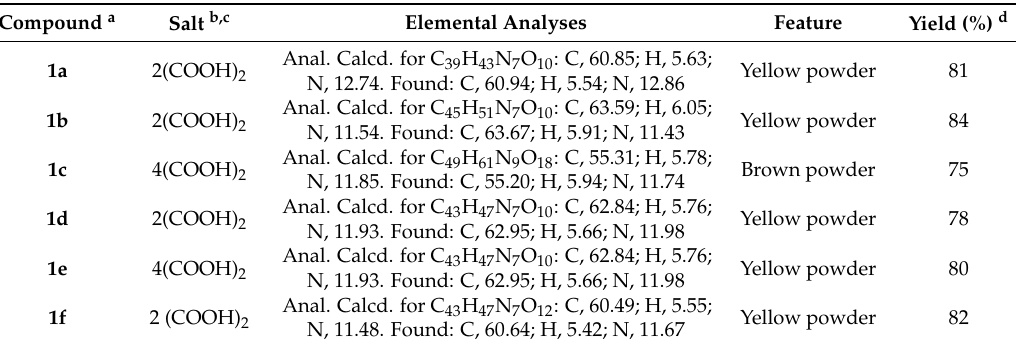
Table 1. Physical properties of ammonium salts 1a – f .